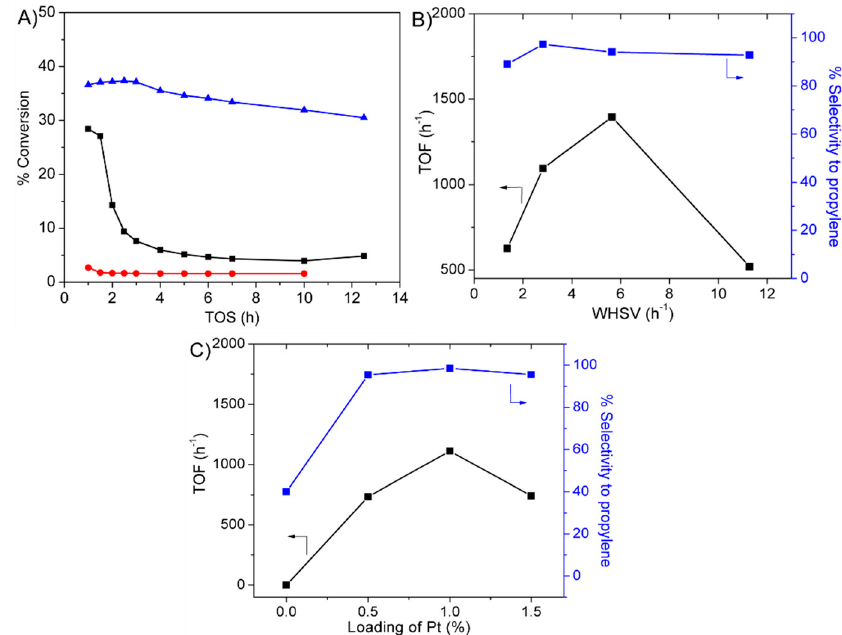
Figure 4. Catalytic performances of propane dehydrogenation over Pt supported hierarchical silicalite- 1 nanosheets with different effects: ( A ) The conversion of propane as a function of TOS over hierarchical silicalite- 1 nanosheets (1% Pt-Si-MFI-NS) (blue), conventional silicalite- 1 (1% Pt-Si-MFI-CON) (red) and alumina (1% Pt-Al 2 O 3 ) (black). ( B ) TOF as a function of WHSV on 1% Pt-Silicalite- 1 nanosheets obtained at TOS of 1 h. ( C ) Effect of Pt loading on hierarchical Silicalite- 1 nanosheets was taken at 3 h of TOS and WHSV of 2.82 h − 1 .